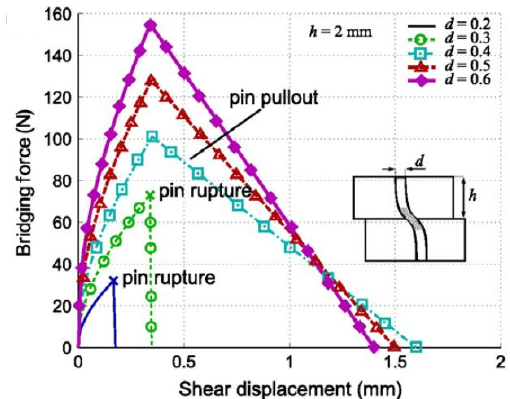
Figure 18. E ff ect of z-Pin diameter on mode II z-Pin response (CFRP z-Pins, t = 2 h = 4 mm, F igure 18. Effect of z-Pin diameter on mode [0] pre-preg) [23]. II z-Pin response (CFRP z-Pins, t = 2 h = 4